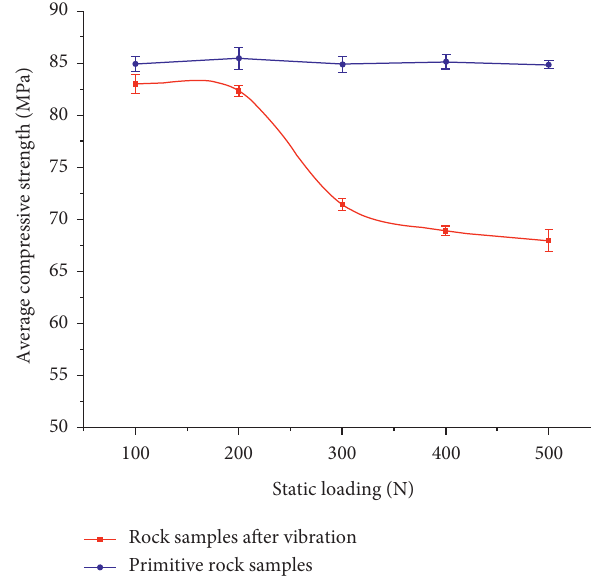
Figure 12: Compressive strength curve of samples with static loading. Figure 13: Rotary ultrasonic drilling